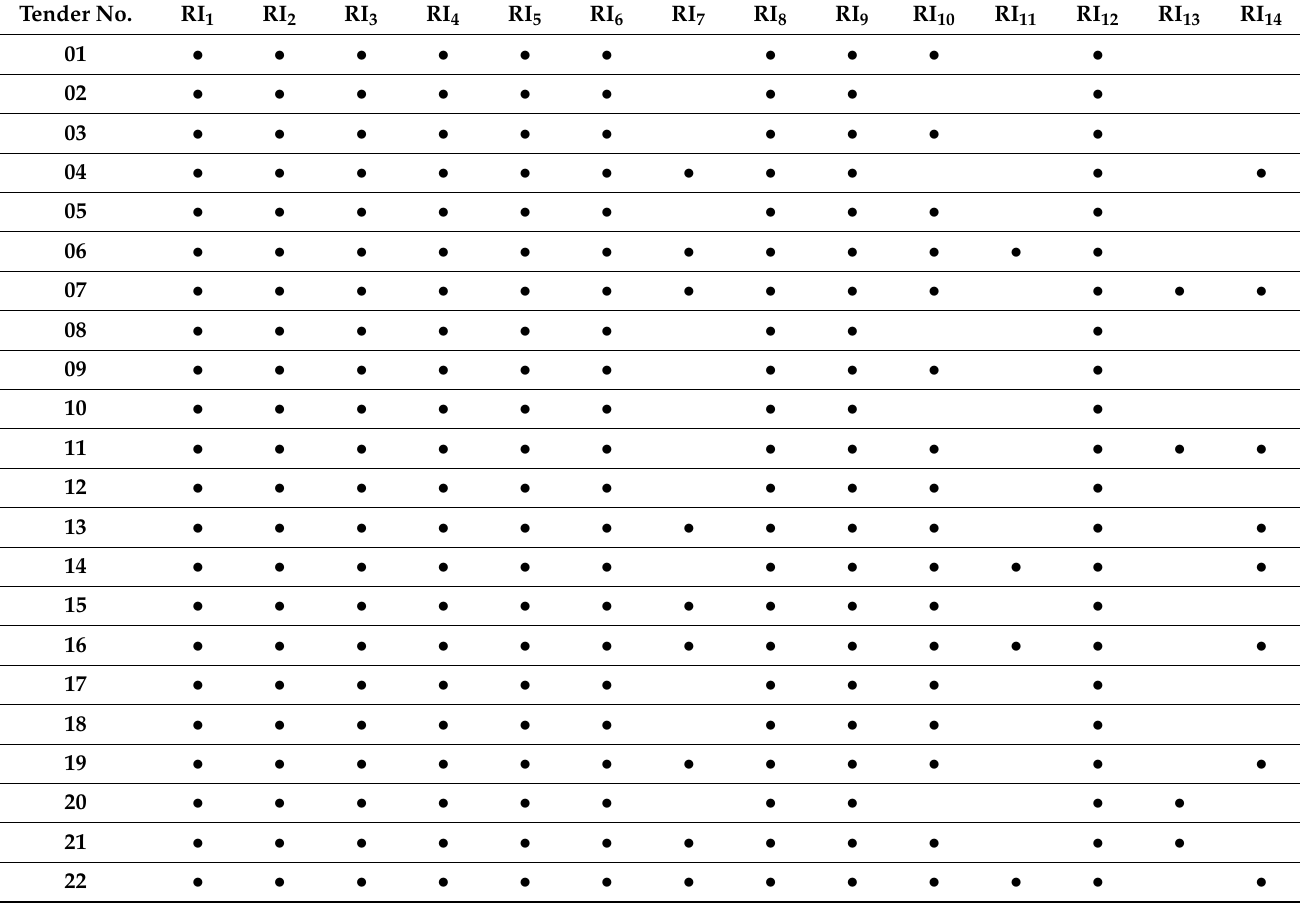
Table 3. Frequency of appearance of the readability issues in the tender